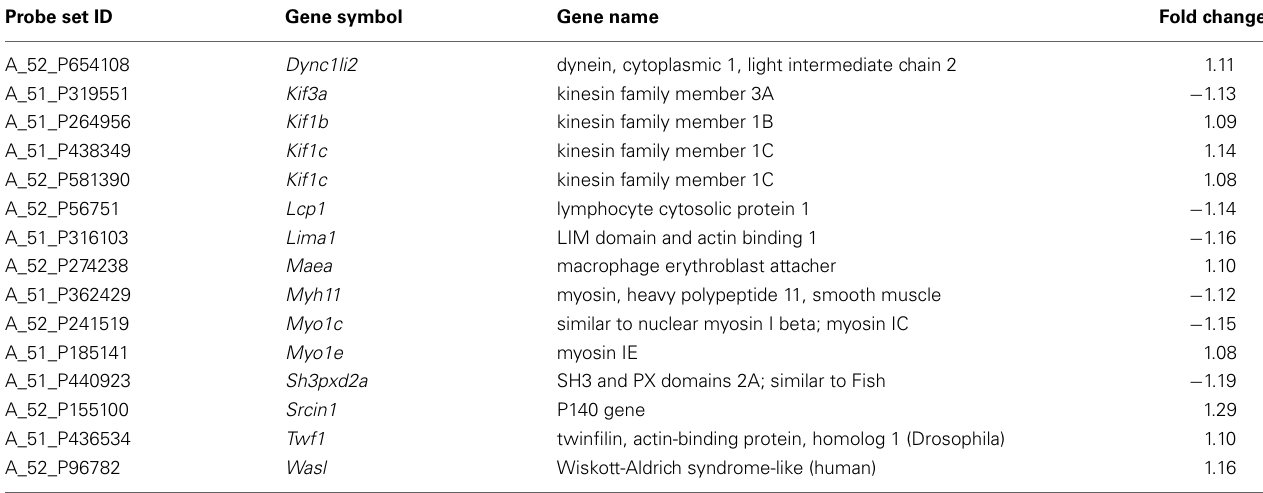
Table 1 | List of differentially expressed genes in spinal cord of 40 days old SOD1 G93A mice related to cytoskeleton. Probe set